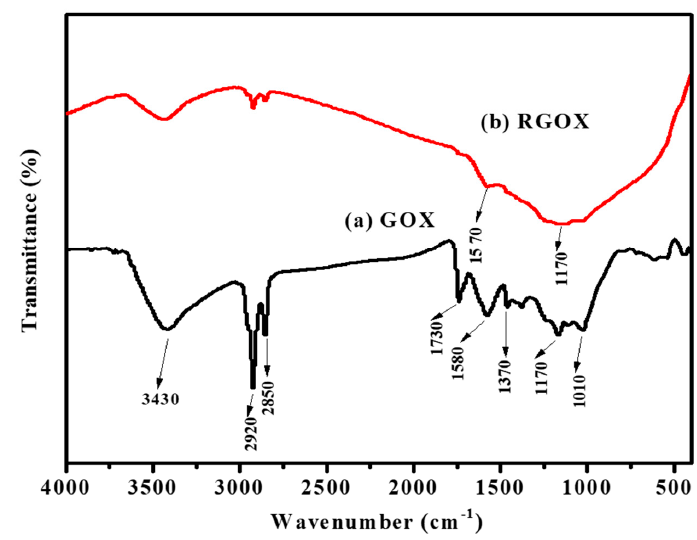
Figure 2. Fourier transforms infrared analysis ( a ) GOX and ( b ) RGOX.